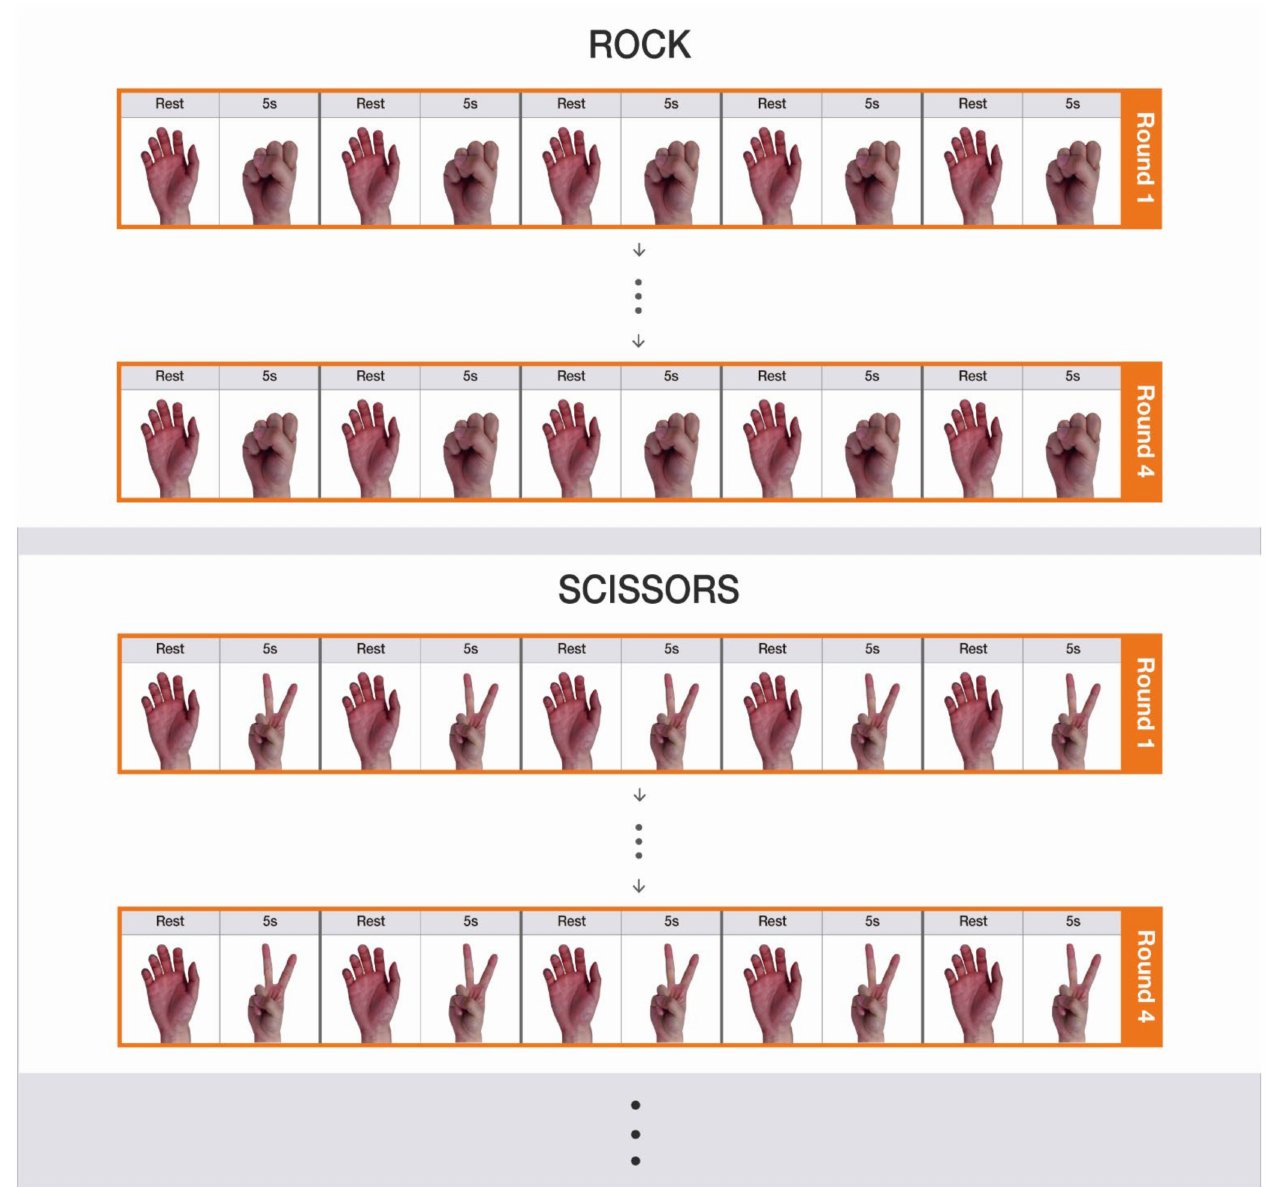
Figure 4. Experimental procedure. Four rounds were conducted for each nine non-rest gesture: rock, scissors, paper, one, three, four, good, okay, and finger gun. The subjects repeated a set of a 5-s rest gesture and a 5-s non-rest gesture five times in each